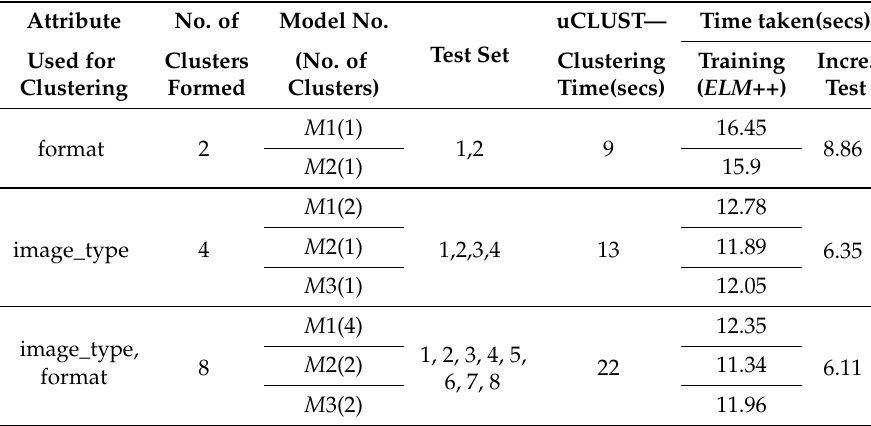
Table 6. Performance Time of CUIL .